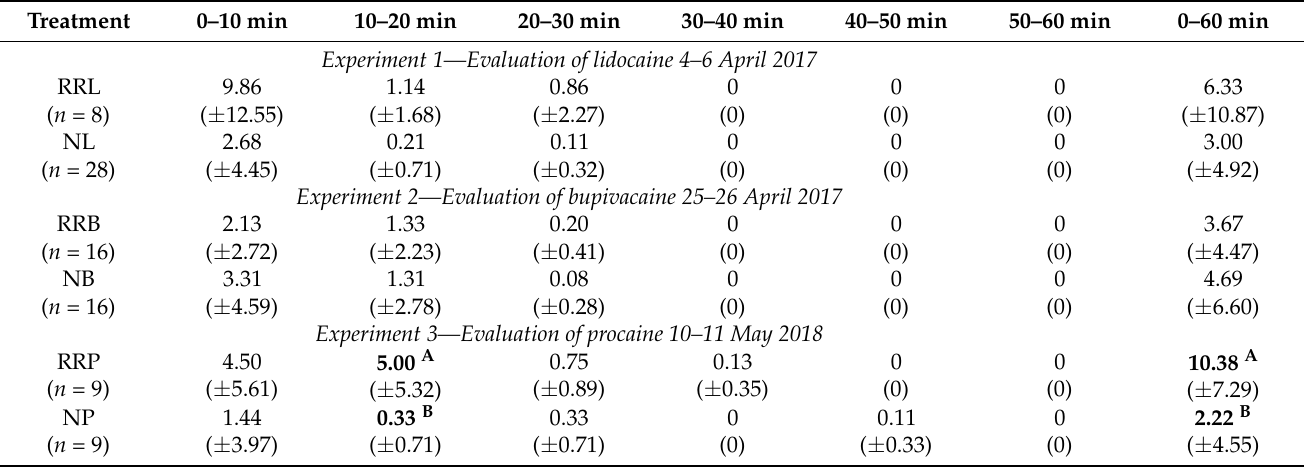
Table 8. Mean ( ± standard deviation) count of foot-stamping or kicking expressed by female lambs. Within each experiment, means within a column with differing uppercase superscripts (A, B) differ significantly ( p < 0.05), while differing lowercase superscripts (a, b) indicate a tendency to differ (0.1 > p > 0.05). RRL ring only, no local anesthetic; NL ring applied with lidocaine administered using the Numnuts ® tool; RRB ring only, no local anesthetic; NB ring applied with bupivacaine administered using the Numnuts ® tool; RRP ring only, no local anesthetic; NP ring applied with procaine administered using the Numnuts ®